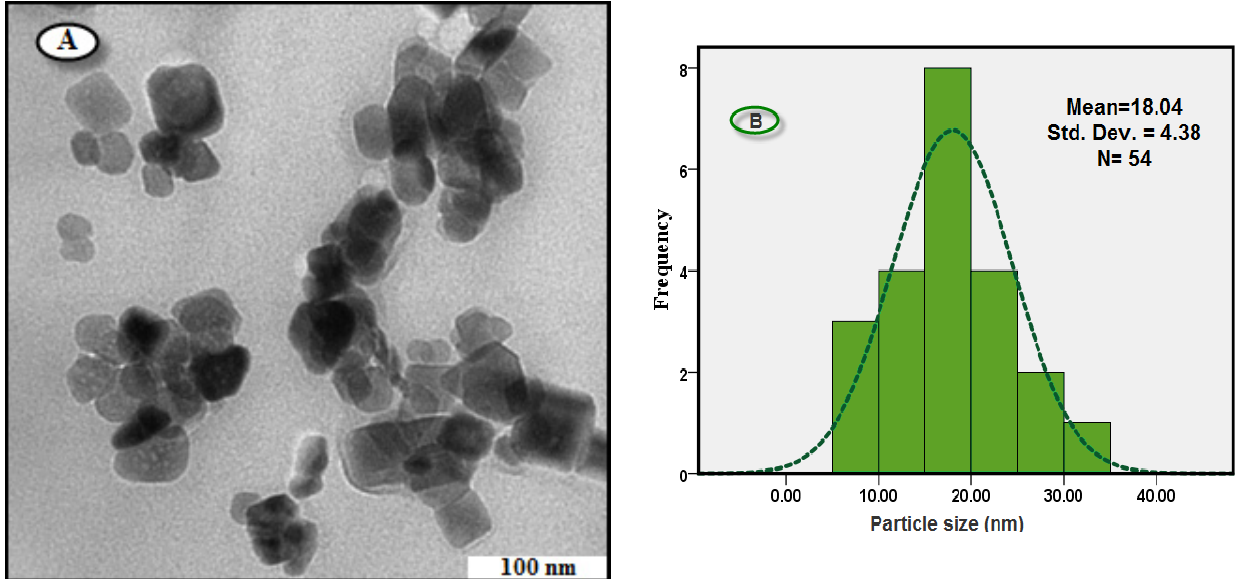
Figure 4. TEM image ( A ), and corresponding size distribution of Fe using BS extract ( B ).